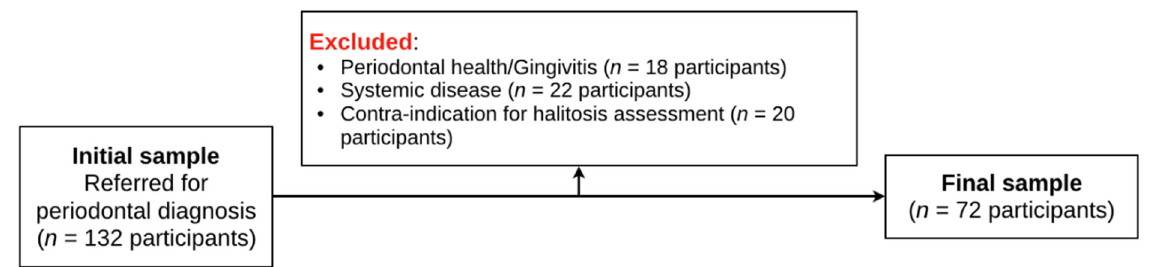
Figure 1. Flowchart of participants.